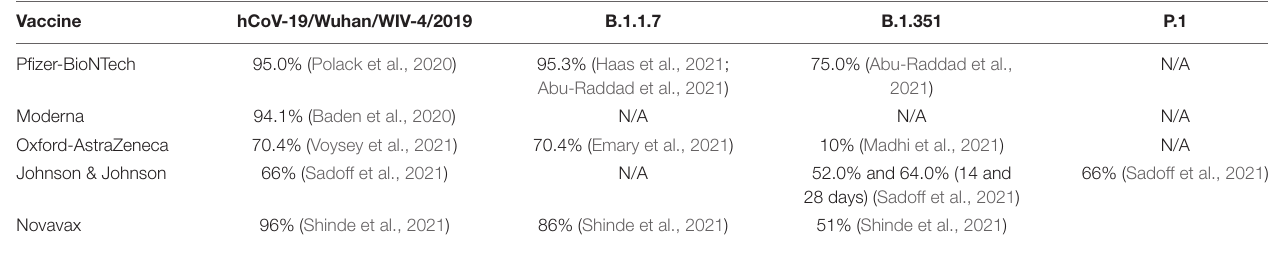
*Mutation frequency as of April 30, 2021. TABLE 5 | Efficacy of vaccines against SARS-CoV-2